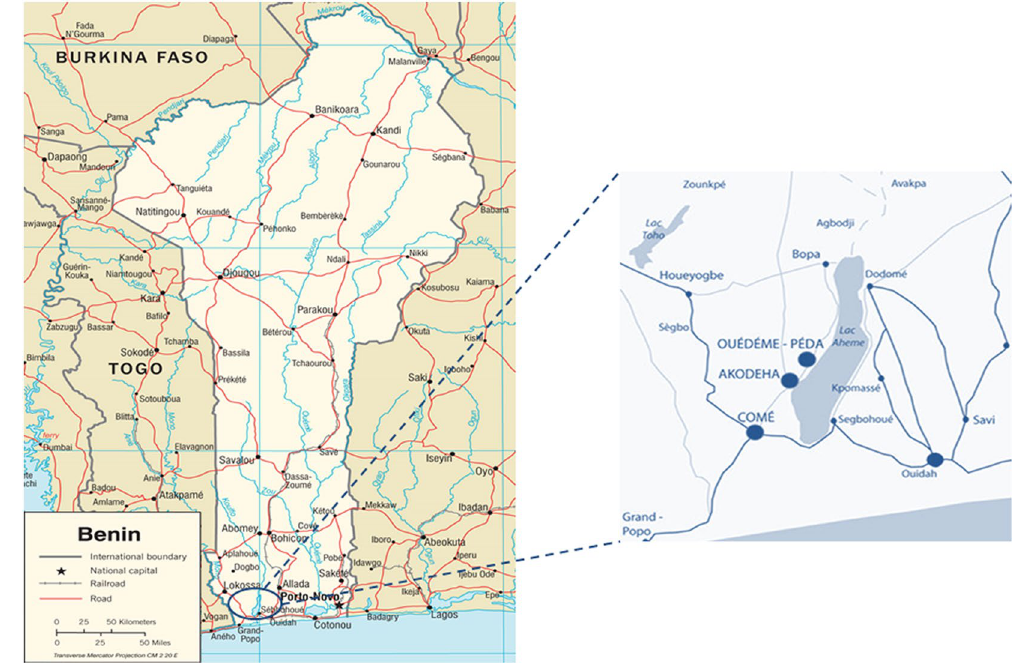
Figure 1. Map of the study area. The study was conducted in Comè District, 70 km west of Cotonou, Benin, where perennial malaria transmission peaks from April to July and September to November. Three dispensaries (Comè, Akodeha, and Ouedeme Pedah), 10 km away from each other, were involved. Comè is a semi-rural area and the two other sites are located in more rural settings. Maps credit: http://www.carte-monde.org/cartes-du- benin/ and P.